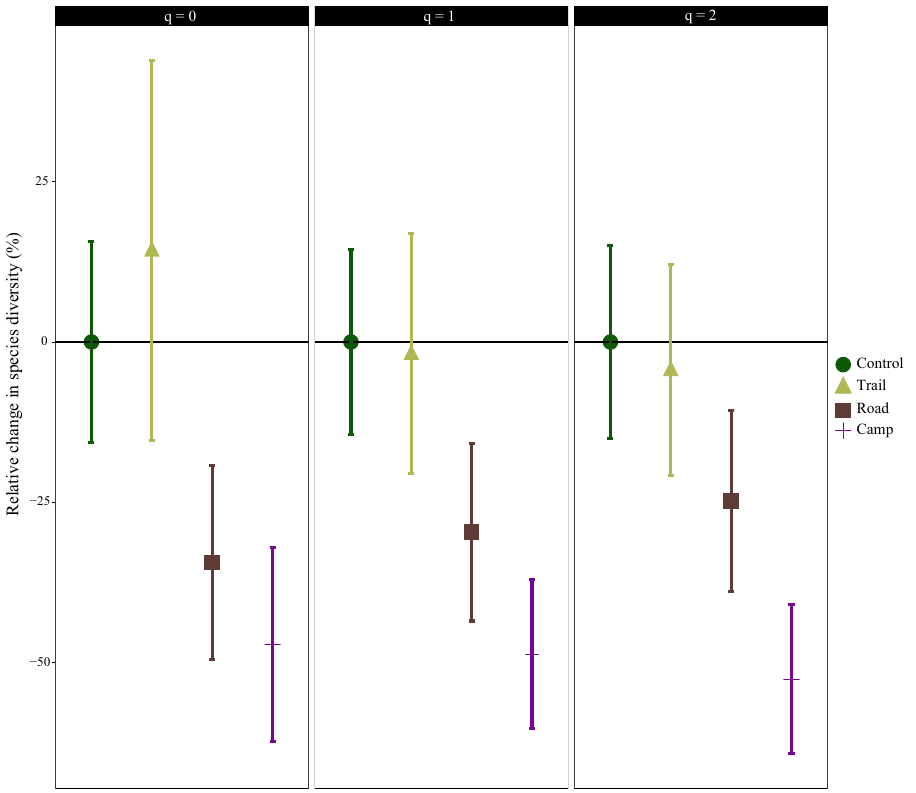
Figure 4. Relative change in species diversity (species richness (q = 0), the exponential of the Shannon–Wiener index (q = 1) and the reciprocal of the Gini-Simpson index (q = 2)) in different plant communities along transects in Khorshid Park compared with the control community value. The error bars are 95% confidence intervals, obtained from a 999 bootstrapping